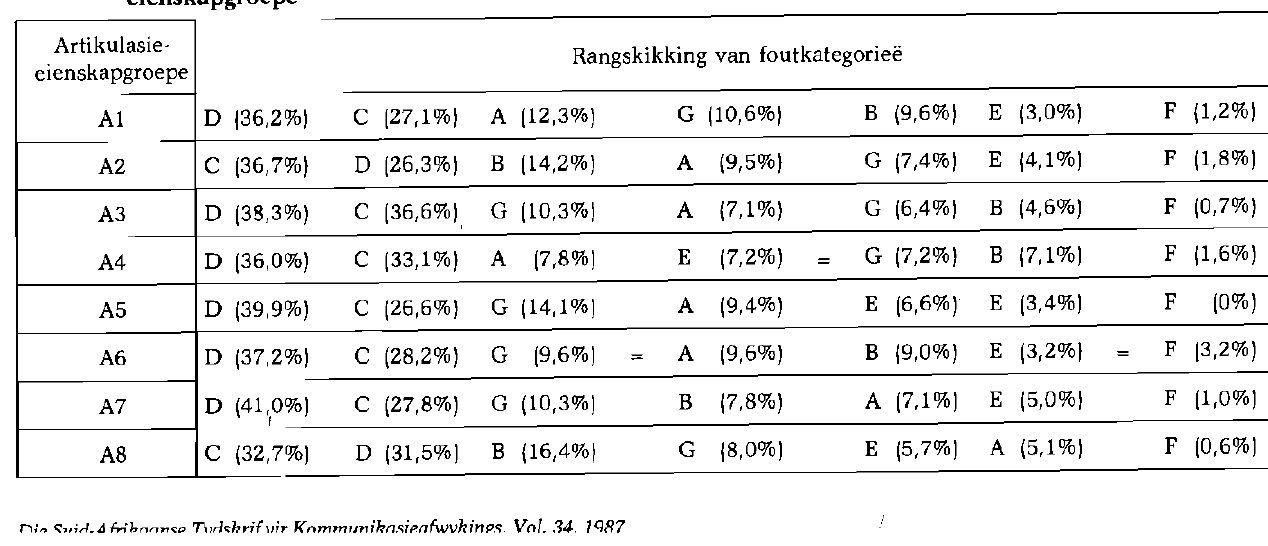
Tabel 7: Rangskikking van foutkategoriee in dalende volgorde van foutvoorkoms by die verskillende artikulasie-